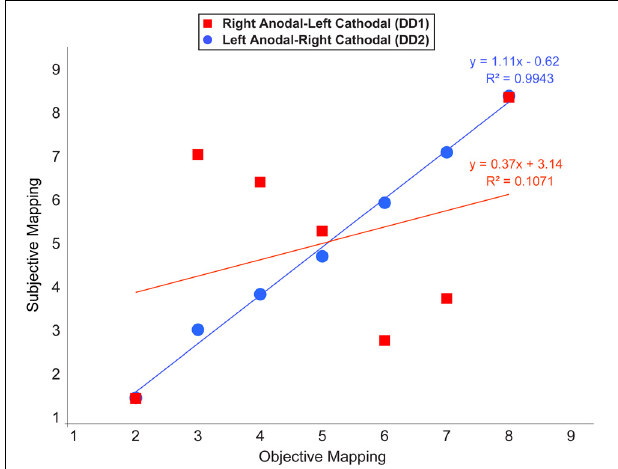
FIGURE 7 | Average location of subjective responses on the number line task plotted for each type of stimulation. Linear regression lines and equations are indicated for each type of stimulation (Red line—Right Anodal-Left Cathodal stimulation received by DD1; Blue line—Left Anodal-Right Cathodal stimulation received by